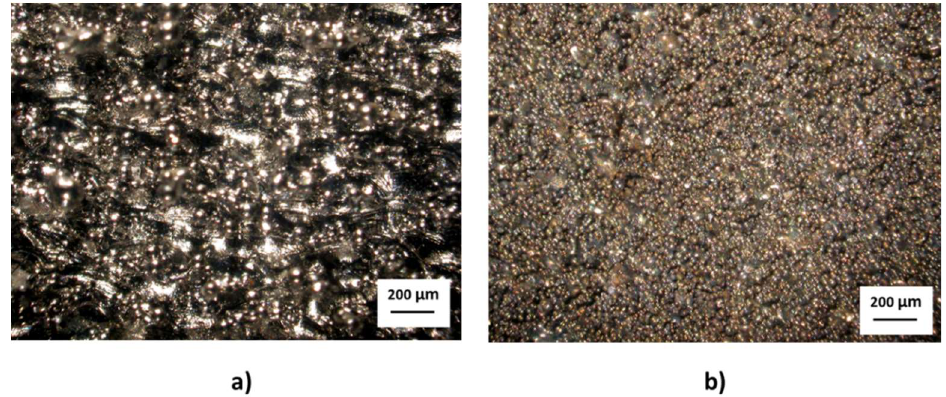
Figure 4. Surface appearance of the “as-produced” additive manufacturing (AM) specimens obtained by optical microscopy: ( a ) EBM and ( b )